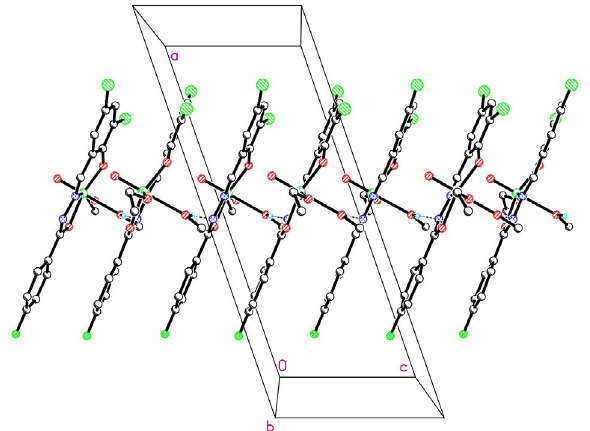
Fig. 2. Molecular packing structure of complex 1 , with hydrogen bonds shown as dotted